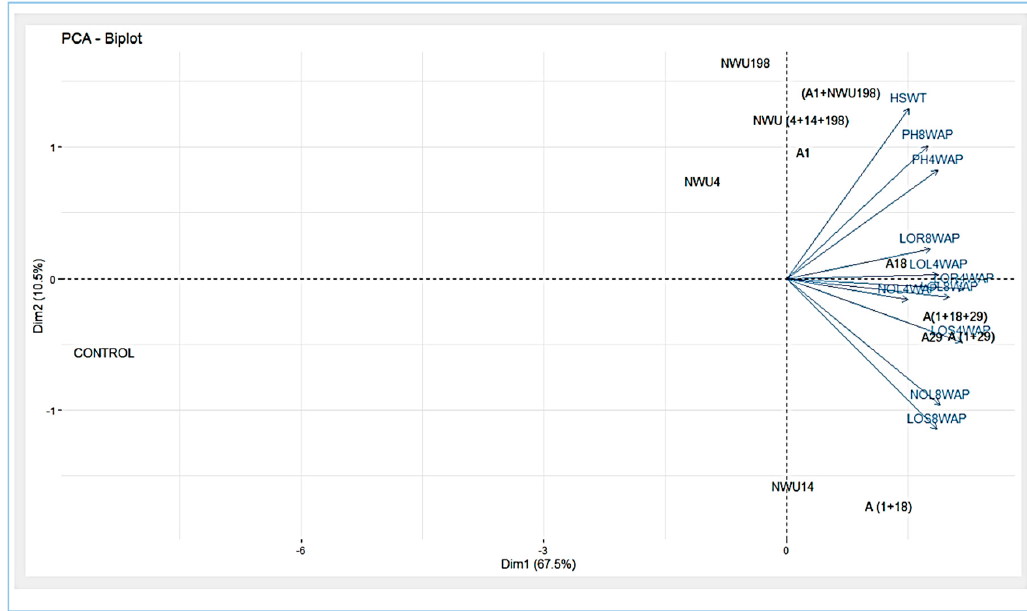
Figure 5. Principal component analysis of growth traits in maize.